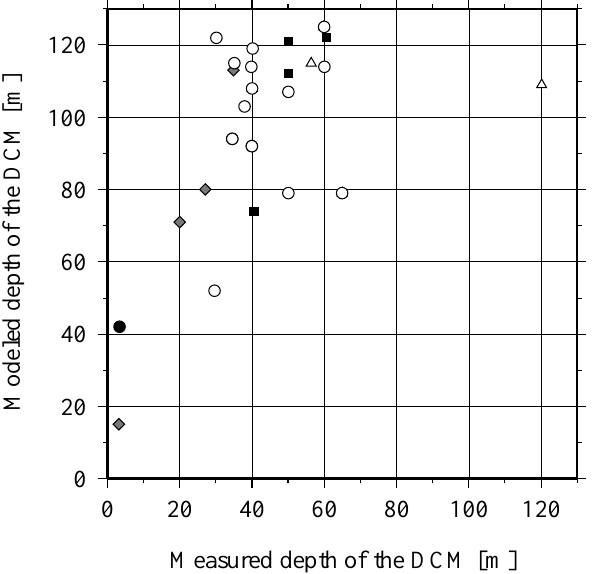
Fig. 11. Predicted versus measured depth of the deep chlorophyll maximum (DCM). Stations from the two river transects are ex- cluded from this comparison because they do not exhibit a DCM (stations 395 to 398, and 691 to 695).